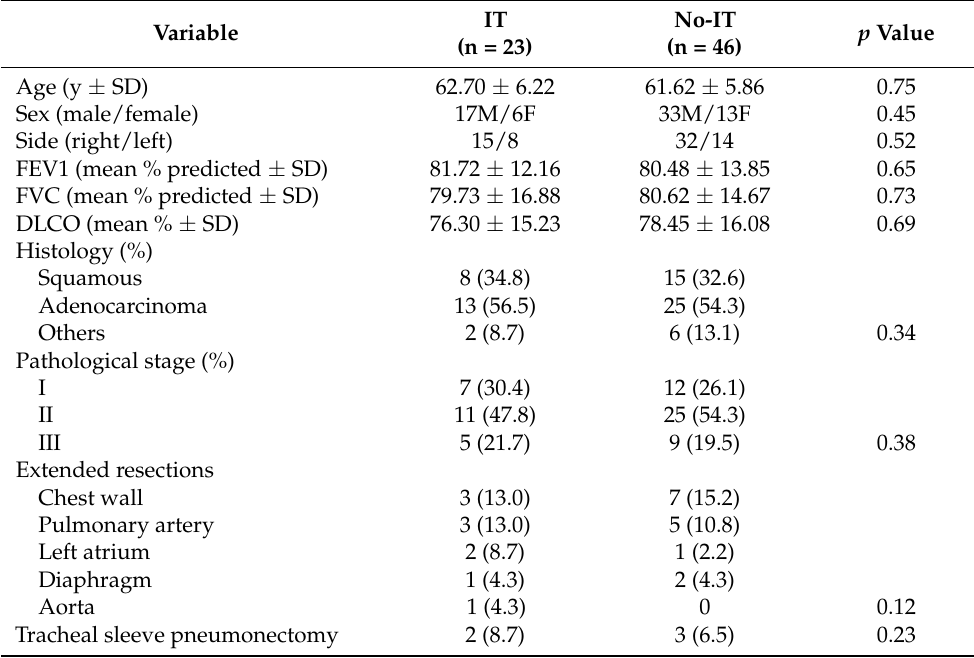
Table 1. Baseline characteristics of the study groups (n =